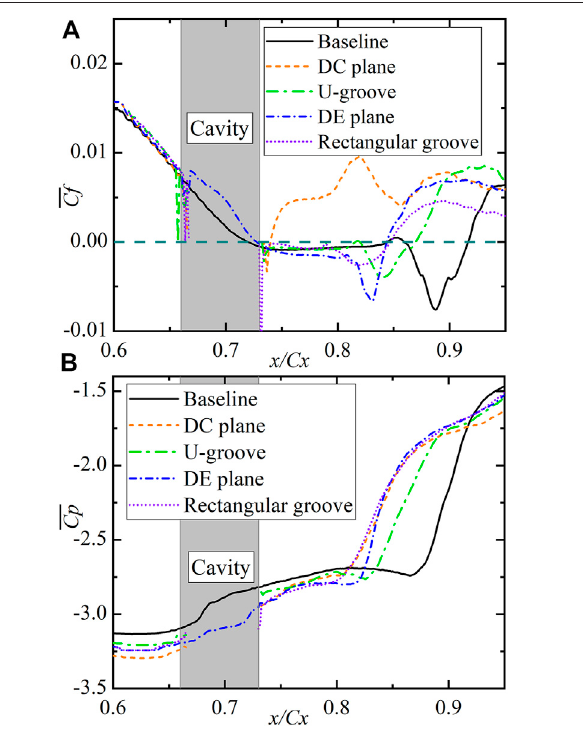
FIGURE 7 | Time- and spanwise-averaged (A) wall-skin friction coef fi cient and (B) wall-pressure coef fi cient distribution for various